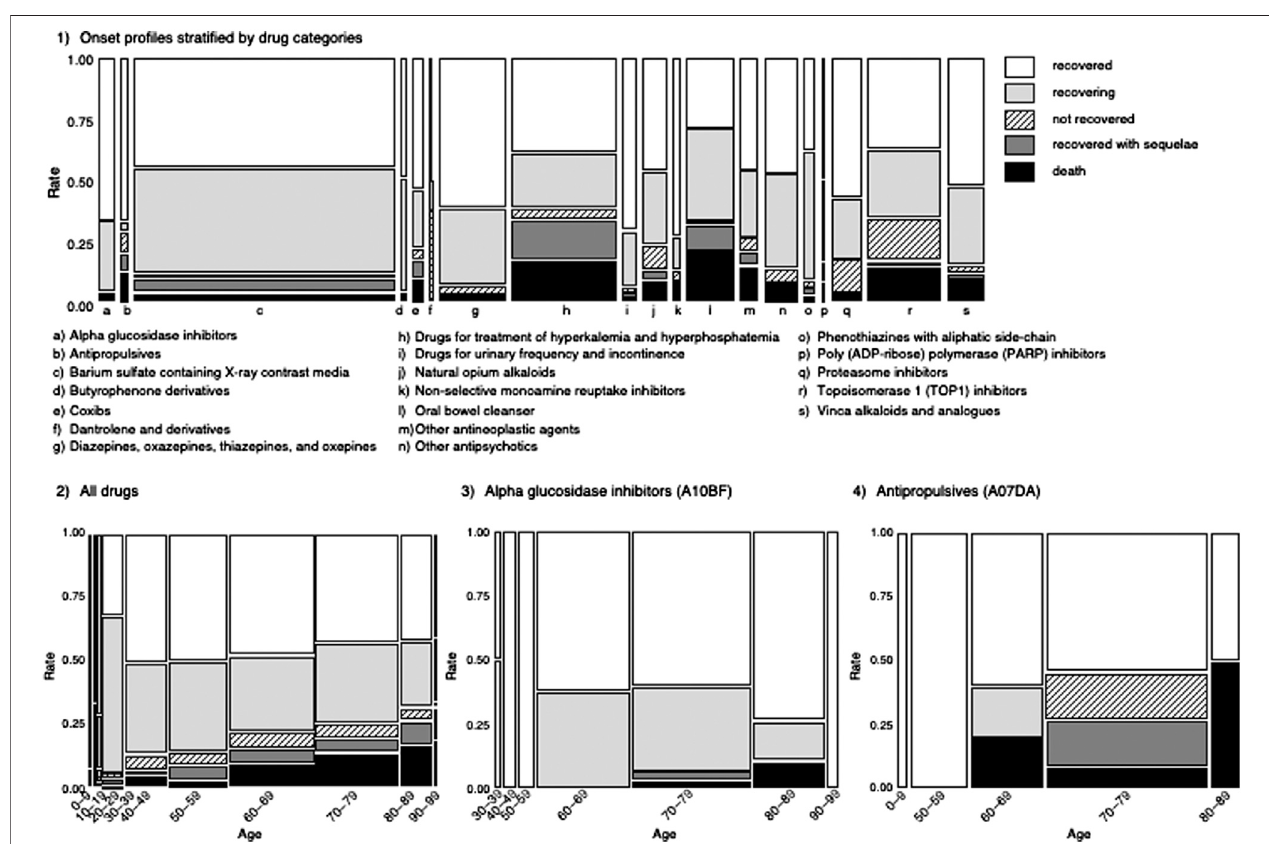
FIGURE 3 | Mosaic plot of drug-induced gastrointestinal obstruction and